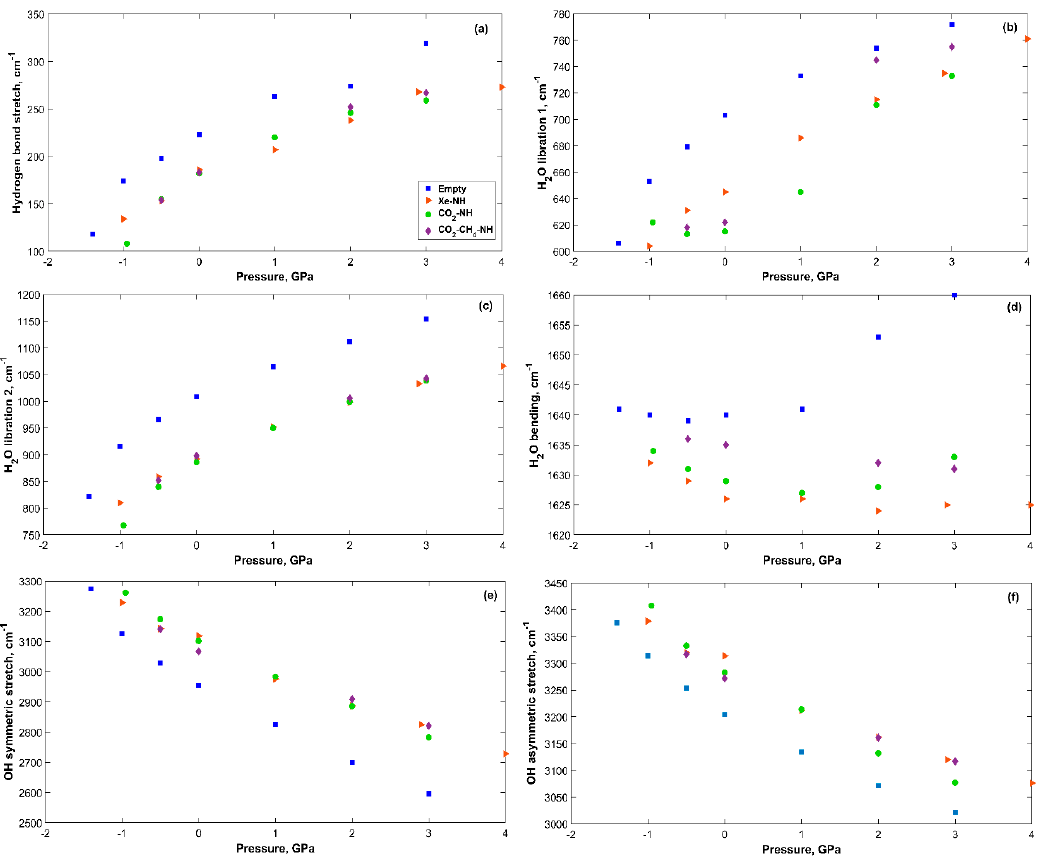
Figure 6. Vibrational modes of H 2 O in sH gas hydrates (see Supplementary Materials) vs. applied pressure. ( a ) Hydrogen bond stretch; ( b ) H 2 O libration 1; ( c ) H 2 O libration 2; ( d ) H 2 O bending; ( e ) OH symmetric stretch; ( f ) OH asymmetric stretch.